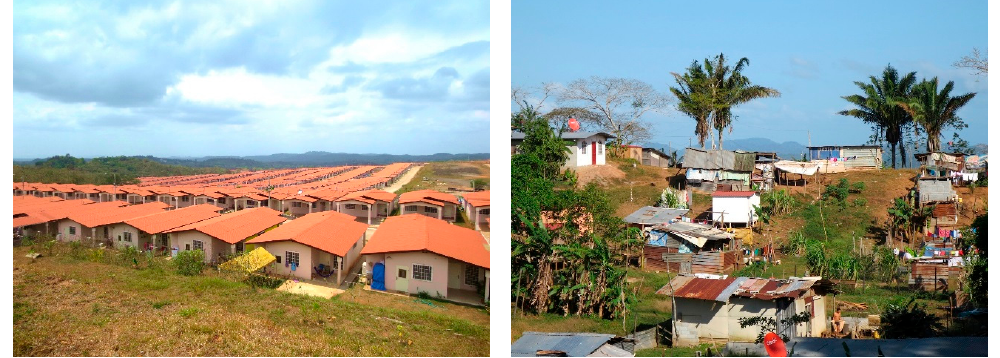
Figure 1. Examples of recent residential growth in Arraij á n. Table 1. Arraij á n Distribution System Vital Statistics (from [26] and interviews with IDAAN